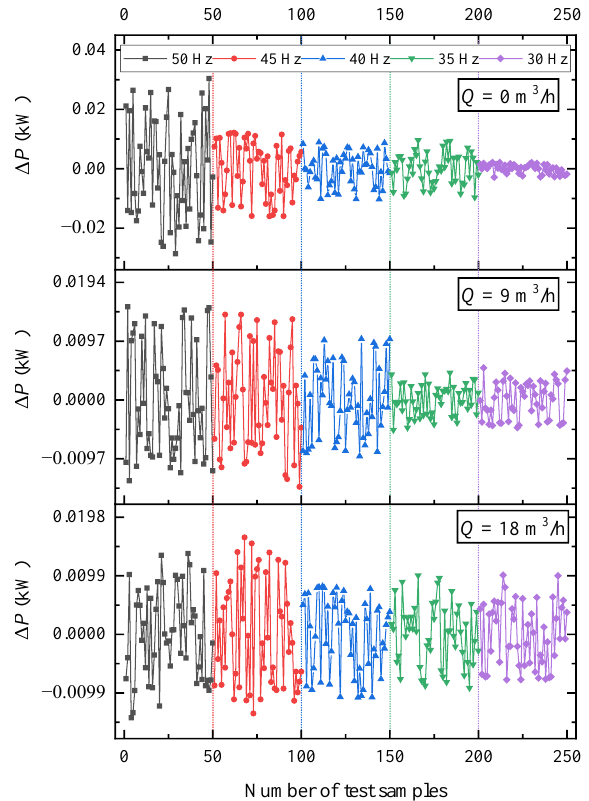
Figure 11. Fluctuation of the shaft power.